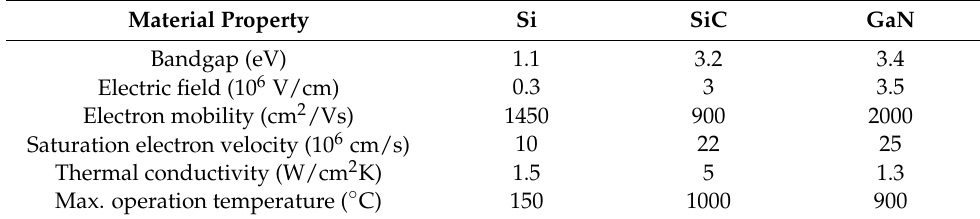
Table 4. Comparisons of the material properties for power transistor